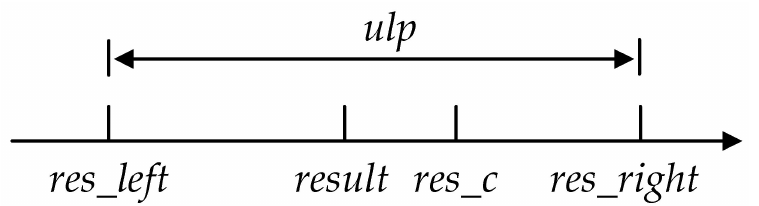
Figure 1. Illustration of ULP. result is the accurate calculation result of the function when the input is ln_ one , whereas res _ left and res _ right denote the two floating-point numbers closest to the accurate result’s left and right, respectively. res _ c represents the approximated result when the input of the function is ln_ one